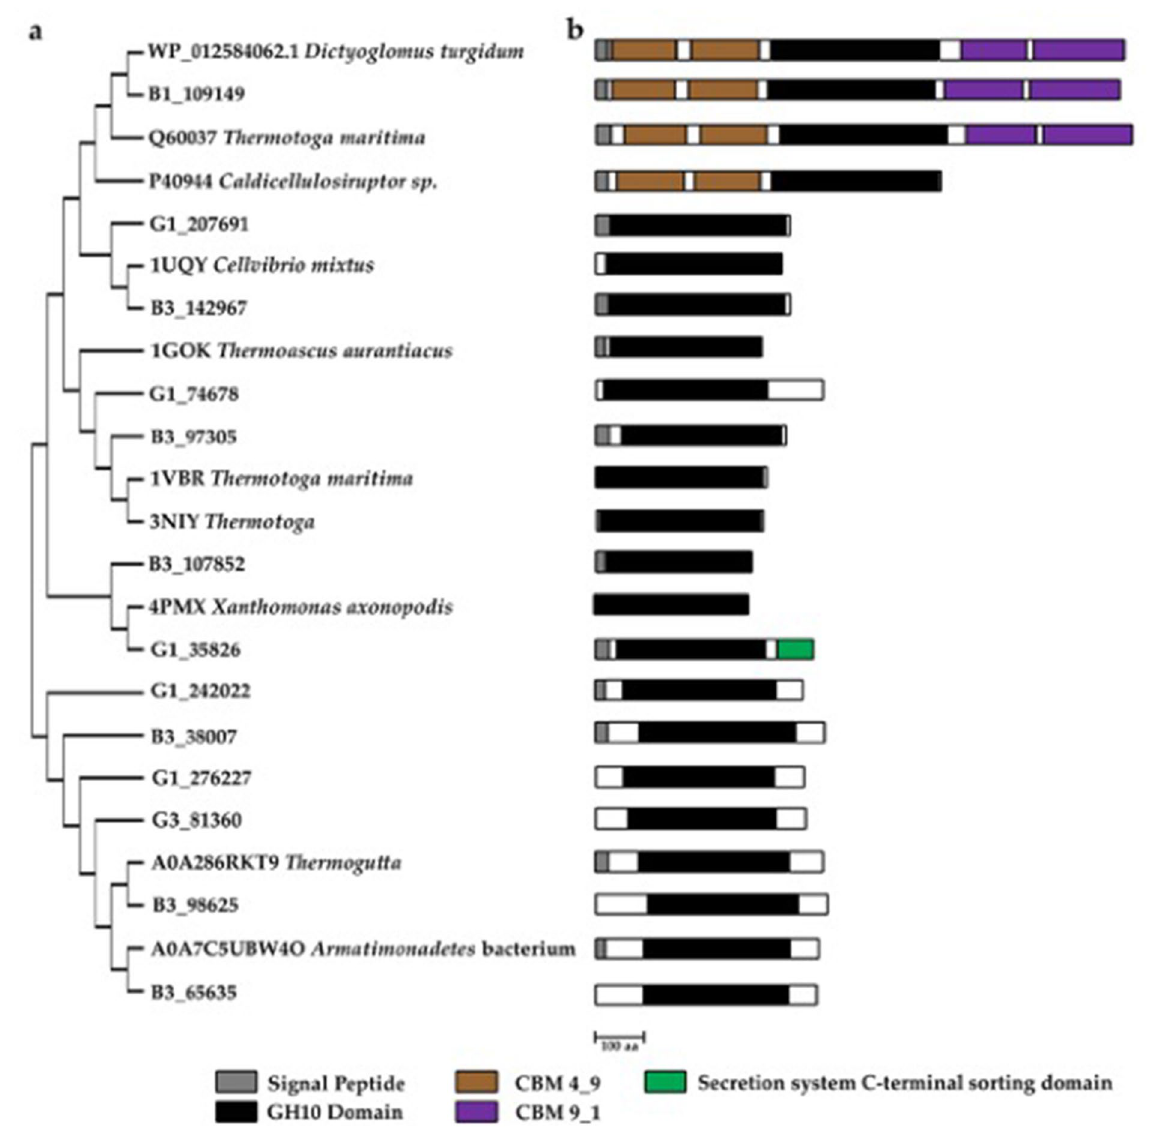
Figure 5. ( a ) Dendogram of xylanases. ( b ) Domains in